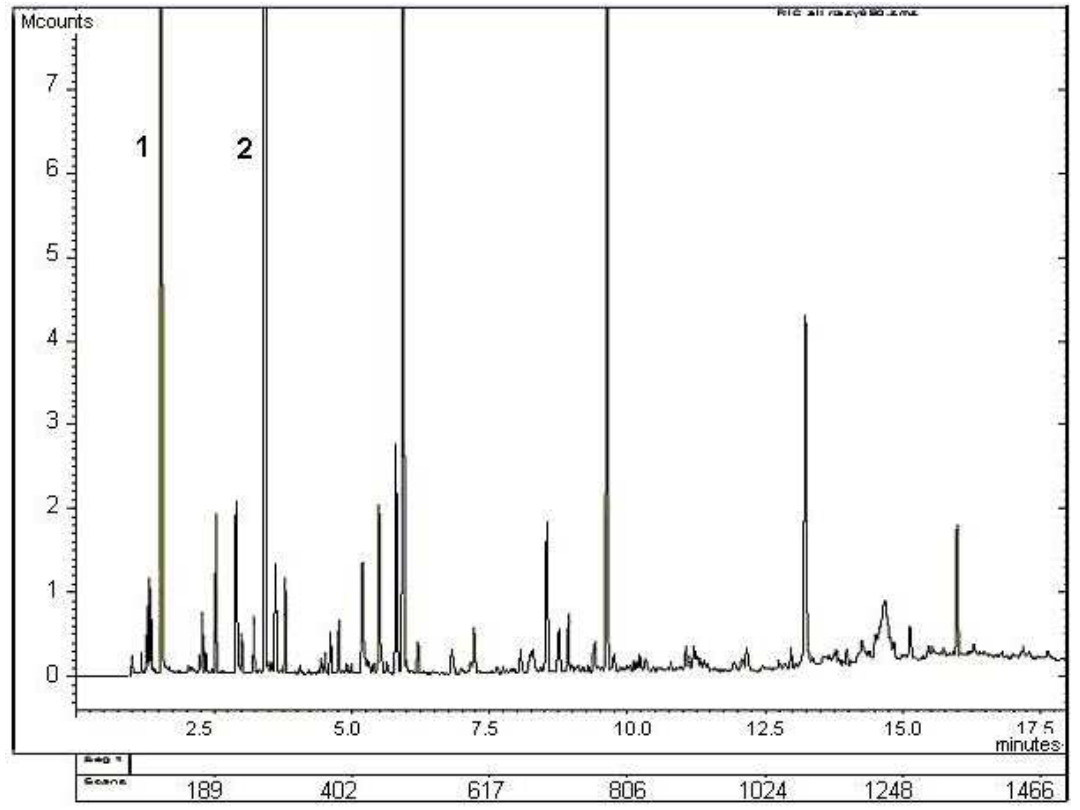
Fig. 2 Pyrogram of Algae ( Chlorella kessleri ) obtained by Py-GC/MS analysis at 850 ◦ C. Column conditions: 30m DB-5 capillary column: inner diameter, 0.25mm, film thickness-0.25 µ m (SGE, Australia). The column temperature was kept at 70 ◦ C for 2 minutes and programmed to 170 ◦ C at the increments of 10 ◦